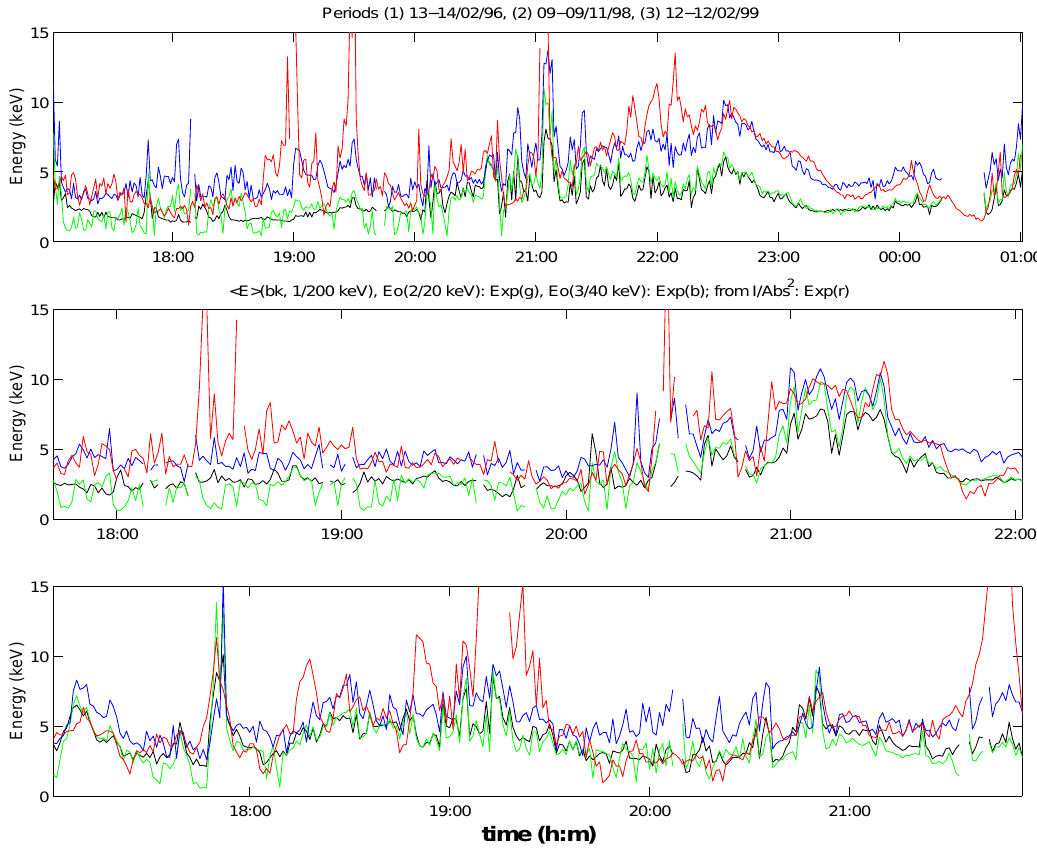
Fig. 5. (Top panel) 13–14 Feb 1996, (middle panel) 9 Nov 1998, and (bottom panel) 12 Feb 1999. In all cases, the black curve shows the flux-averaged energy h E i over the full spectrum in the 1–200keV range. The green and the blue curves give, respectively, the estimated Eo from log( F 2 /F 1 ), for two exponential distributions, the first in height range 98–120km ( E 1 = 20keV and E 2 = 2keV) and the second in height range 89–117km ( E 1 = 40keV and E 2 = 3keV). The red curve gives the values of Eo from log(Int/Abs 2 ) for an exponential